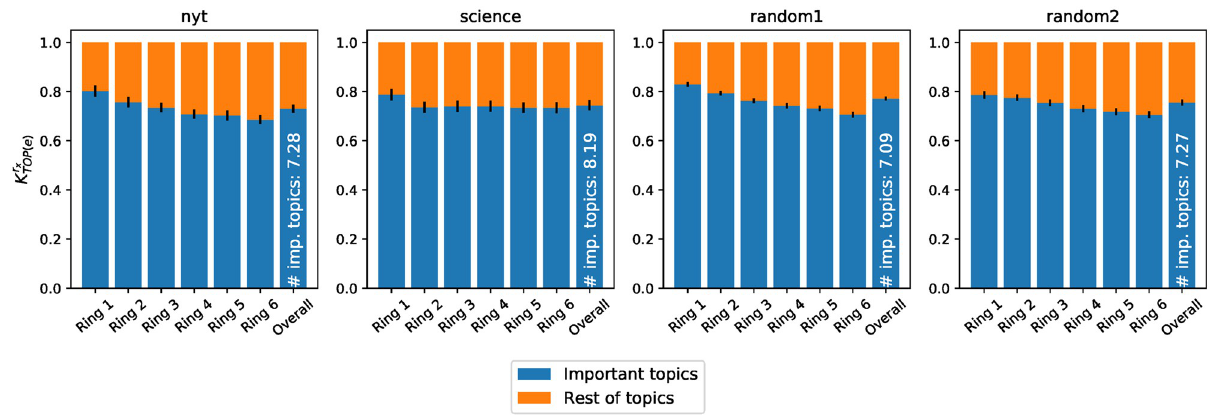
Fig 17. Average strength of the ego network’s important topics in the semantic profile of each ring. The blue part of the stacked bar represents the share covered by the important topics in U e . The average number of topics | U e | is specified in white.